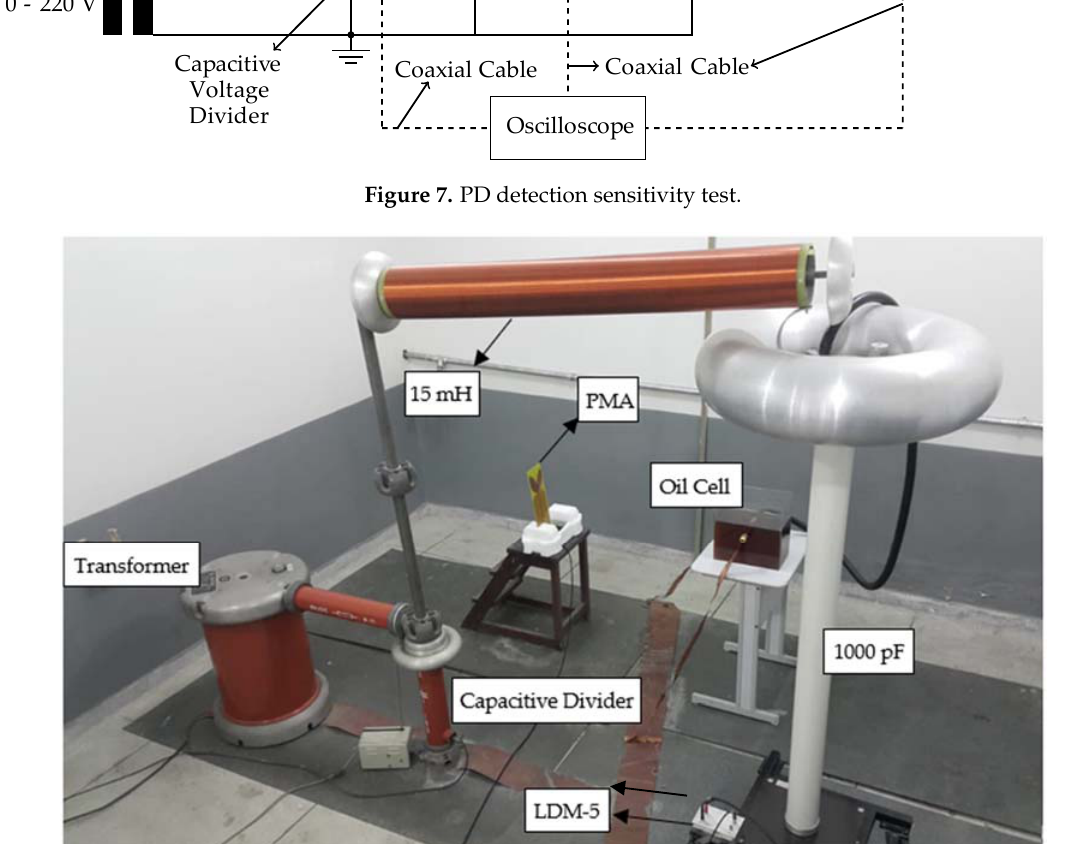
Figure 8. PD detection sensitivity test setup. Table 1. Calibration apparent charge data for the applied PD generator oil